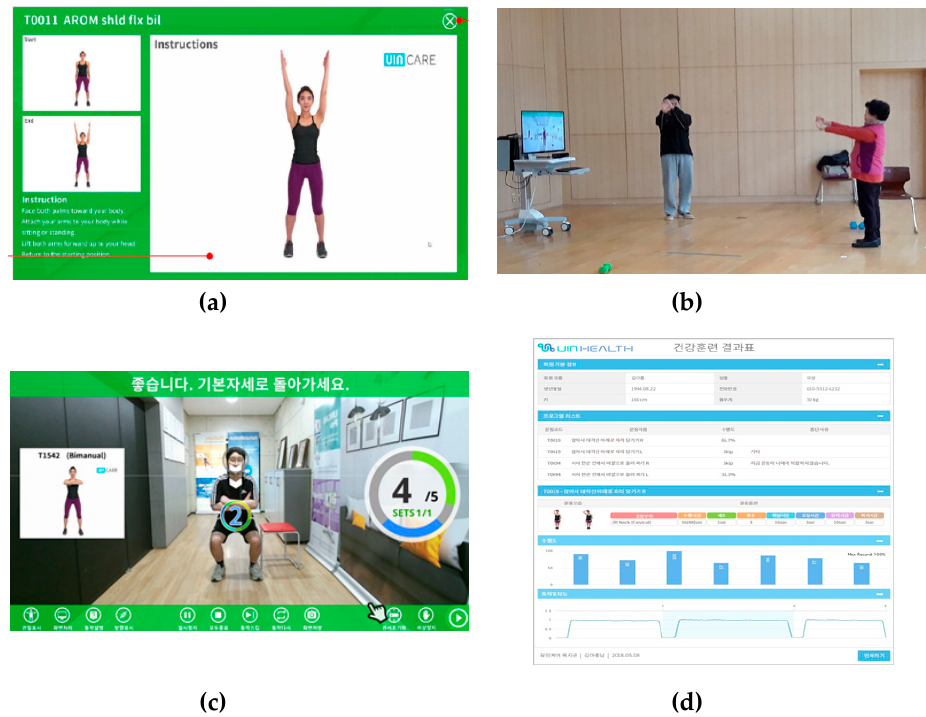
Figure 3. Augmented-reality-based exercise program in UIN-HEALTH. ( a ) Configuration of the contents of the muscle reduction prevention exercise by the exercise specialist; ( b ) content execution and safety management by exercise specialist during exercise; ( c ) exercise situation monitoring on monitors; and ( d ) results of exercise and feedback